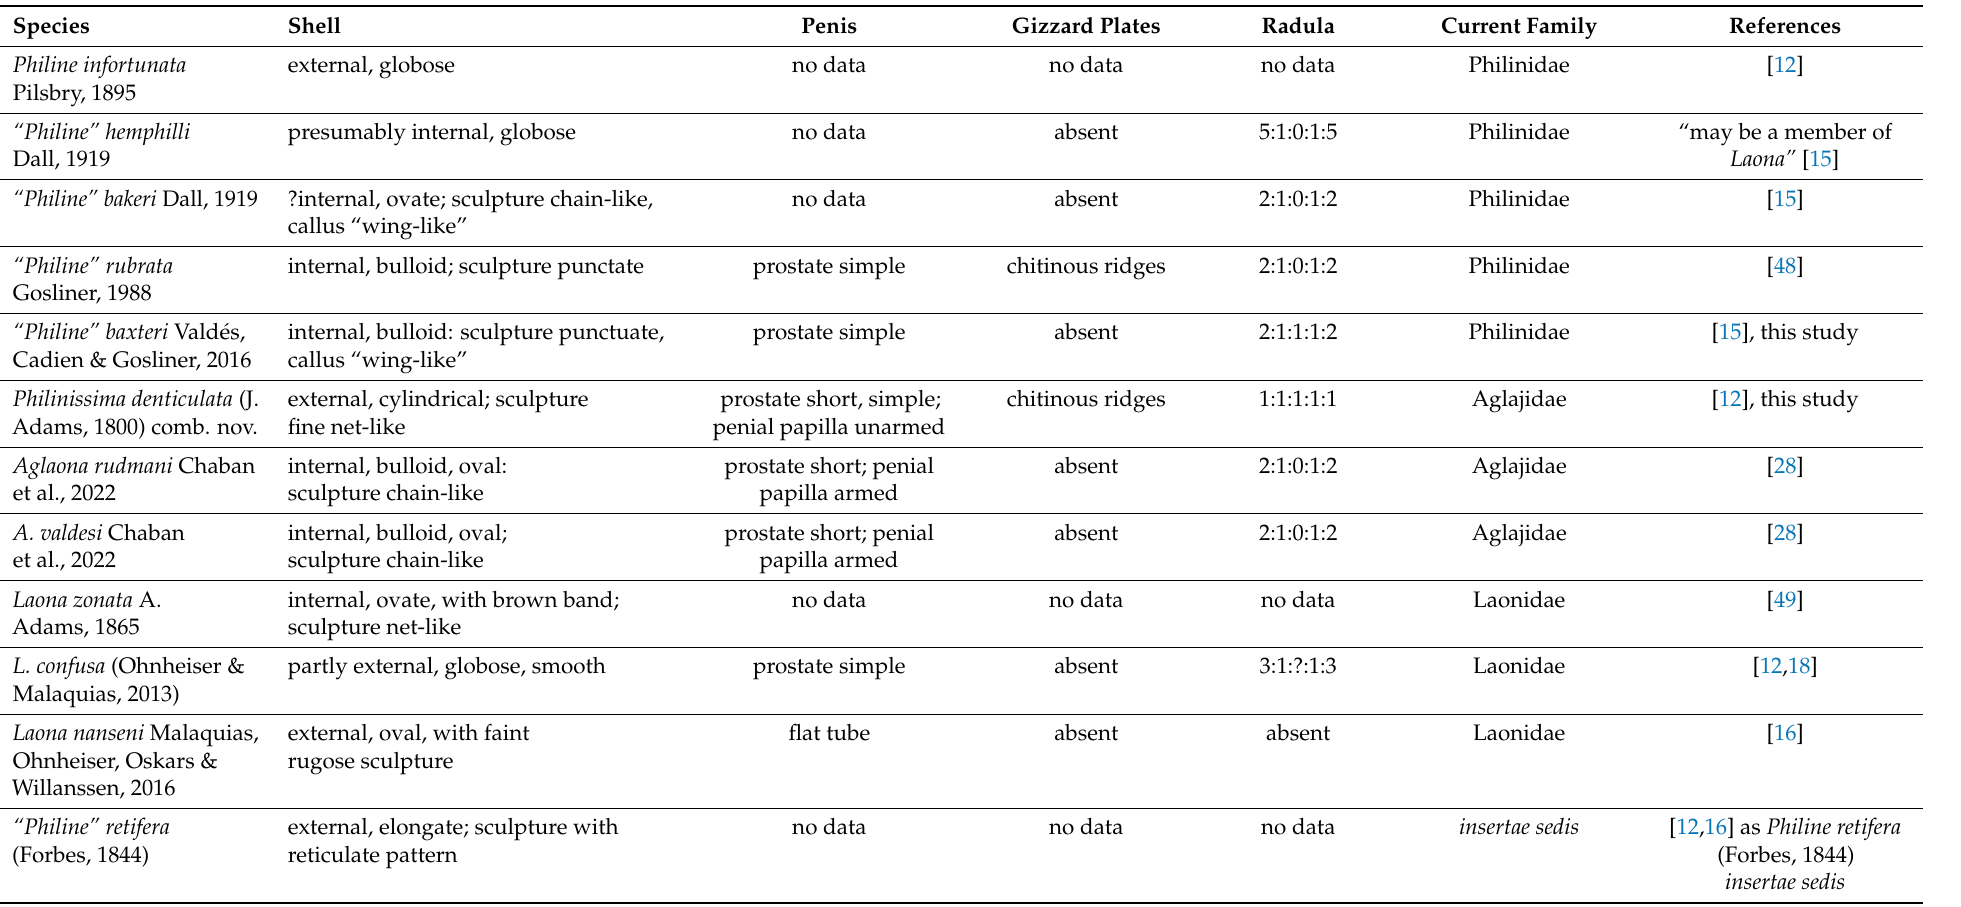
Table 3. Comparative morphology of species of the families Philinidae, Laonidae, and Aglajidae with developed shell and without gizzard